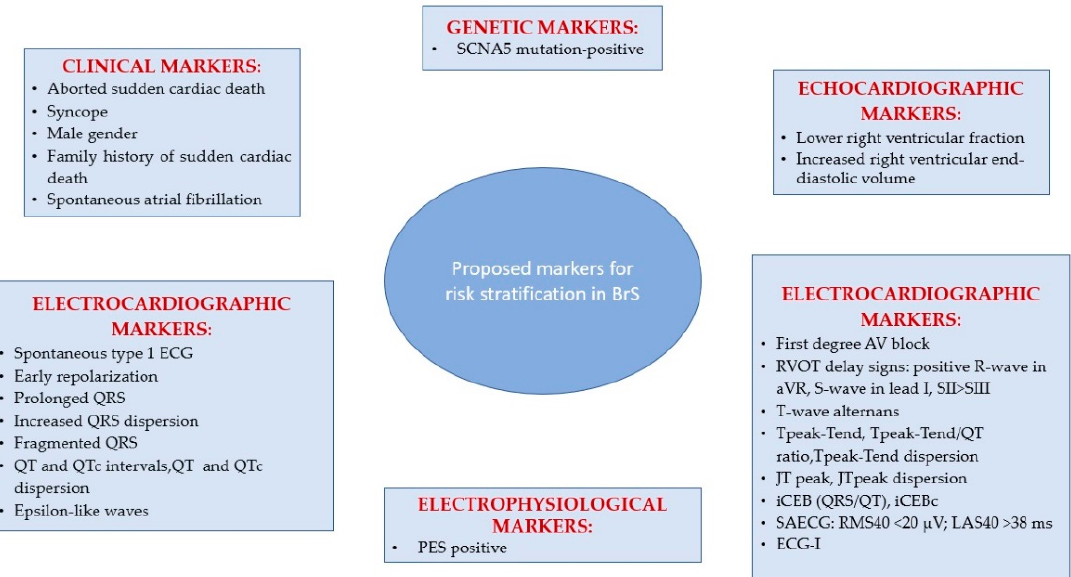
Figure 2. Schematic representation of the proposed markers for risk stratification in Brugada syn- drome; BrS (Brugada syndrome); SCN5A (sodium channel protein type V subunit α gene); RVOT (right ventricle outflow tract); PES (programmed electrical stimulation); AV (atrioventricular); iCEB (index of Cardiac Electrophysiological Balance); SAECG (signal-averaged ECG); RMS40 (root mean square voltage of the QRS complex terminal 40 ms); LAS40 (duration of low amplitude signals <40 µV of the QRS complex); ECG-I (electrocardiographic imaging).